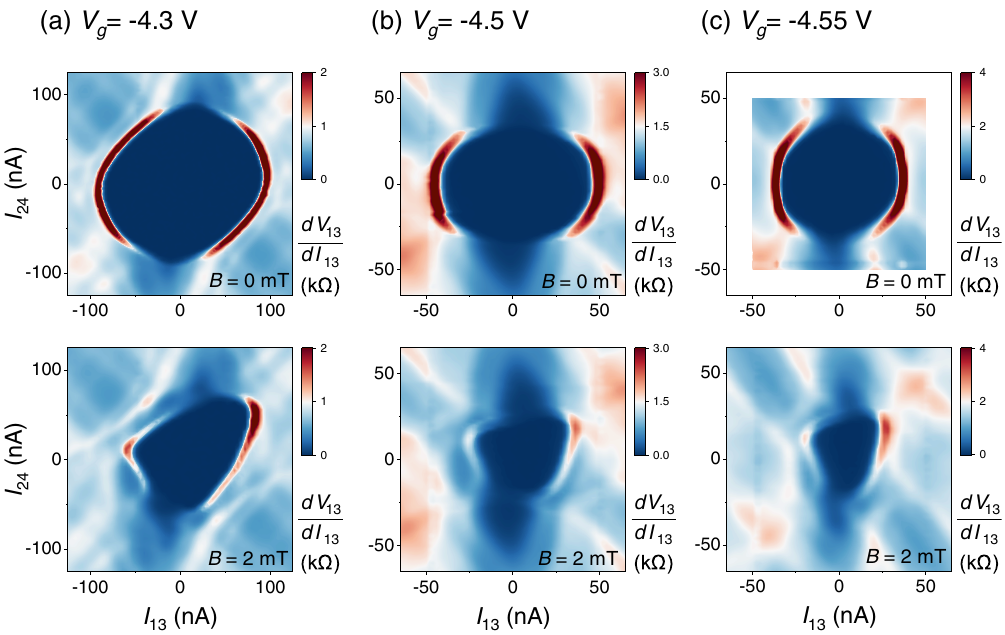
FIG. 5. Effect of top gating on a four-terminal junction. (a) – (c) Differential resistance map in the ð I 13 ; I 24 Þ plane taken at three values of the top-gate voltage at B ¼ 0 (top row) and at B ¼ 2 mT (bottom